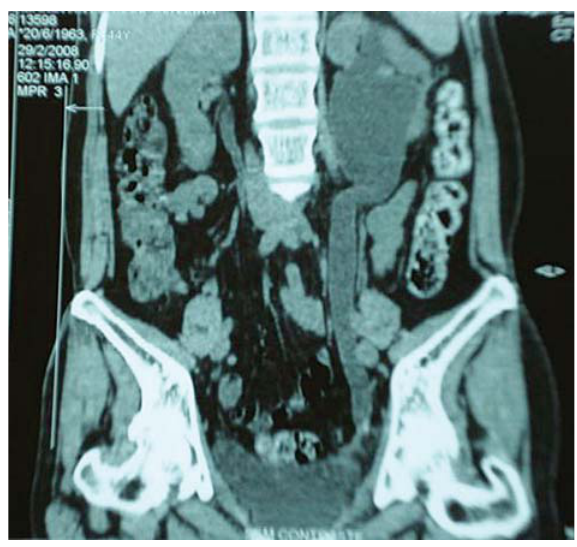
Figure 1 – Abdominal CT scan of a 44 year old woman showing a left distal ureteral stenosis after an endoscopic ureterolithotripsy for a impacted ureteral stone.